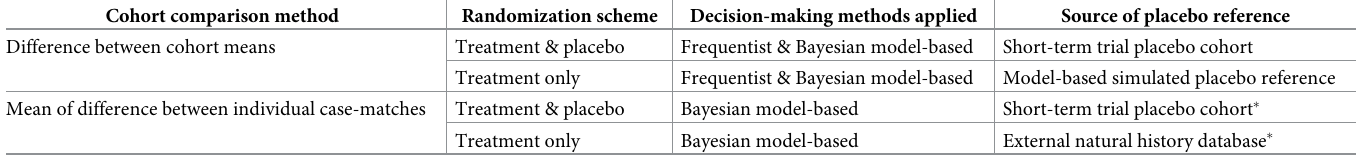
Table 1. Conditions of the model-based Bayesian analyses based on the implemented treatment comparison methods and decision-making